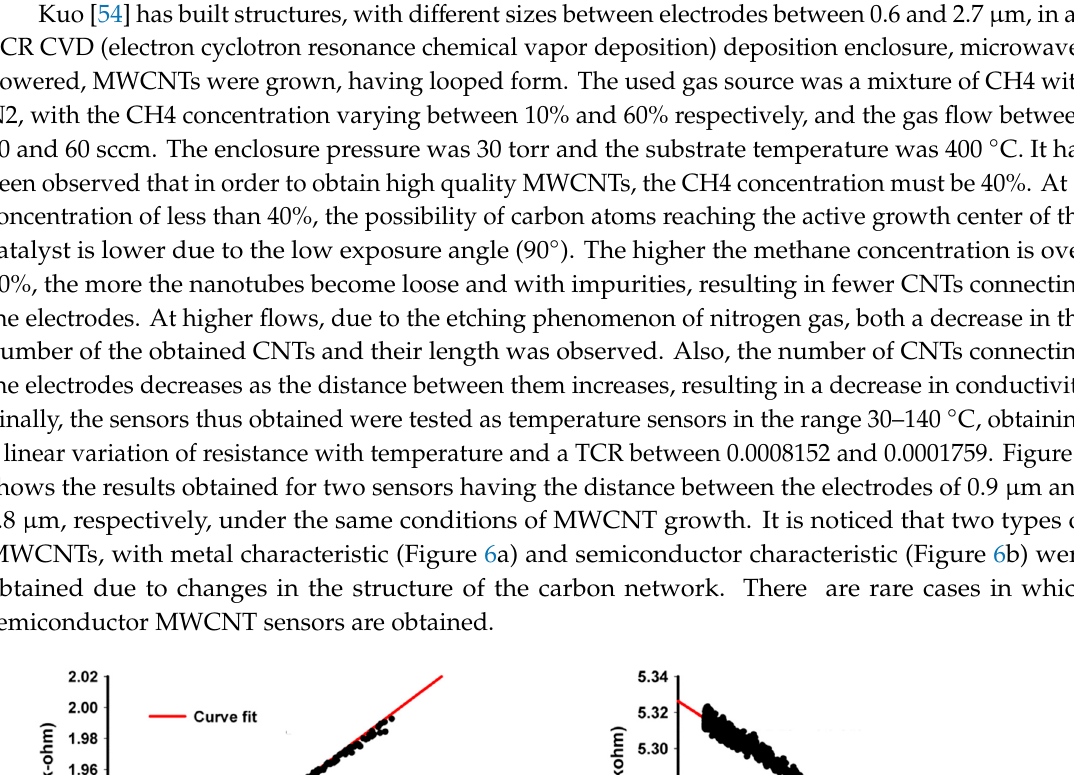
Figure 5. Temperature–resistance curve. © 2010 IEEE. Reprinted, with permission, from [29].